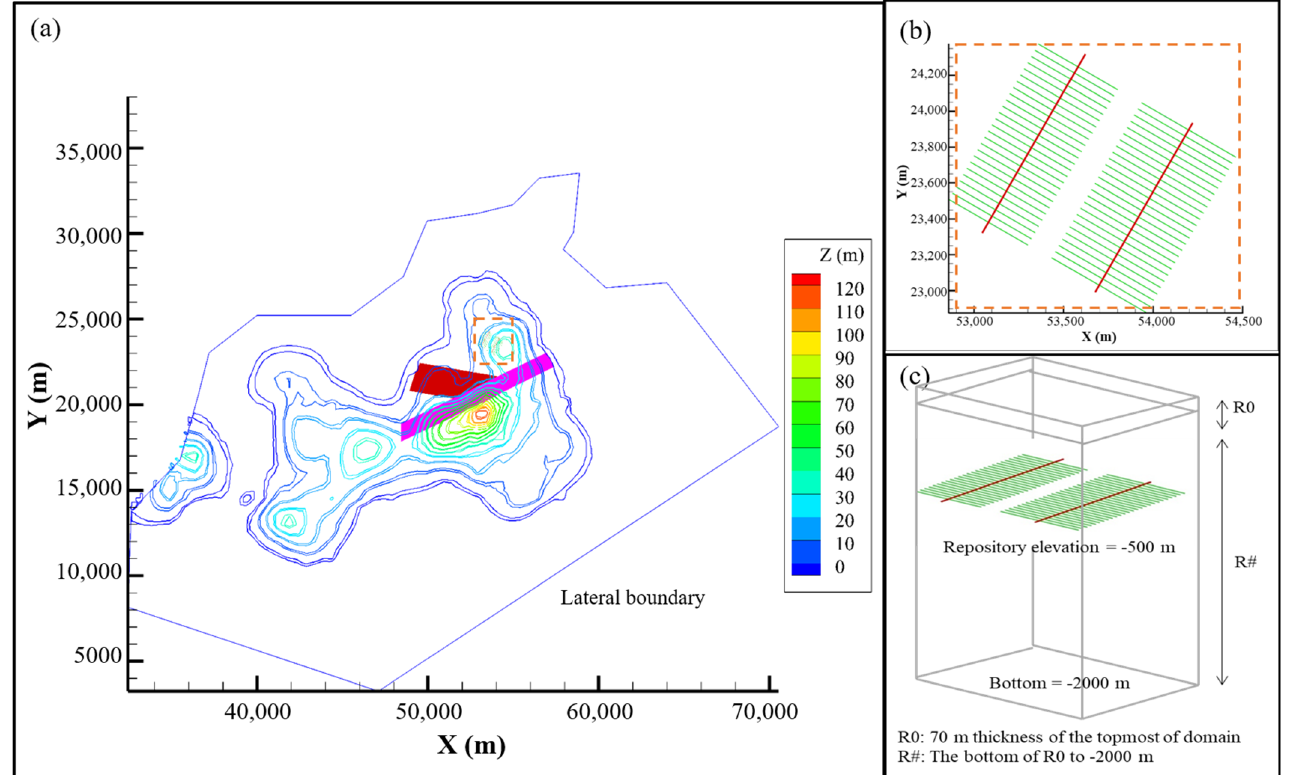
Figure 3. The hydrogeological conceptual model for the reference case: ( a ) The land and sea and the salinity (3.2% for sea) are considered in the model. There are two faults, including F1 (in pink) and F2 (in dark red), in the eastern area. The conceptual repository is in the northeast area of the simulation domain (marked with a dashed line); ( b ) The close view of the conceptual repository defined in ( a ); ( c ) The depth of the bottom boundary and the repository